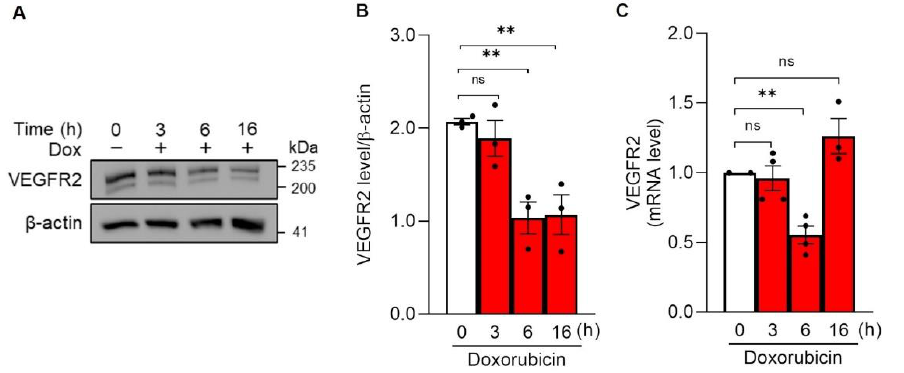
Figure 2. VEGFR2 protein levels decrease early following Doxorubicin treatment. HUVECs were incubated with 250 nM Doxorubicin and samples were collected at the indicated time during the treatment, red histogram. White histogram represents the not treated cells. ( A ) Representative immunoblot of HUVEC lysates analyzed using an antibody against VEGFR2. ( B ) Quantification of VEGFR2 protein level by densitometric analysis. Data are shown as mean ± SEM of protein level normalized to β -actin. n = 3 independent experiments per condition. ns p > 0.05, ** p < 0.01, by unpaired Student’s t test. ( C ) mRNA level of VEGFR2 determined by qRT-PCR. Each sample was normalized to β -tubulin and data are expressed as fold increase compared to the untreated sample. Data are shown as mean ± SEM of n = 3 – 4 independent experiments per condition. ns p > 0.05, ** p < 0.01 by unpaired Student’s t